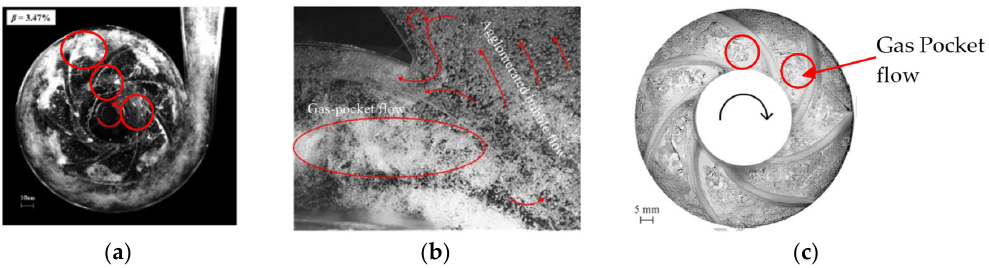
Figure 12. Visualization of bubbles in previous study. ( a ) Zhang [39] IGVF = 3.47, ( b ) Si [36] IGVF = 4%, and ( c ) Verde [8] IGVF = 2.78%.